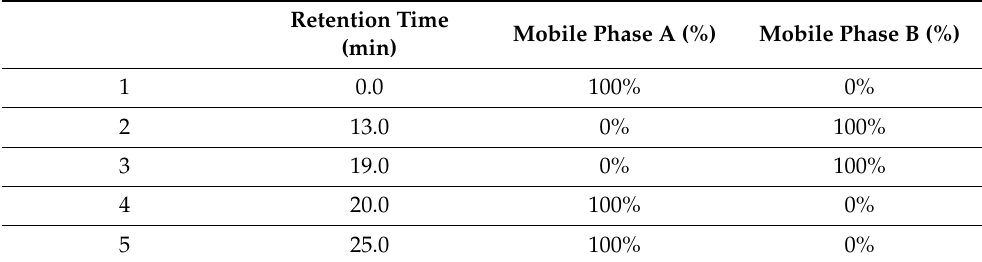
Table 3. HPLC/DAD analysis of yeast lipid metabolites: changes in mobile phase composition during gradient elution.